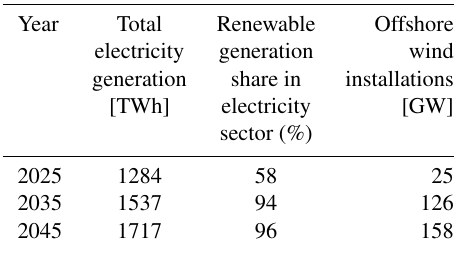
Table 5. Offshore wind power installations per country for the sce- nario with sector coupling